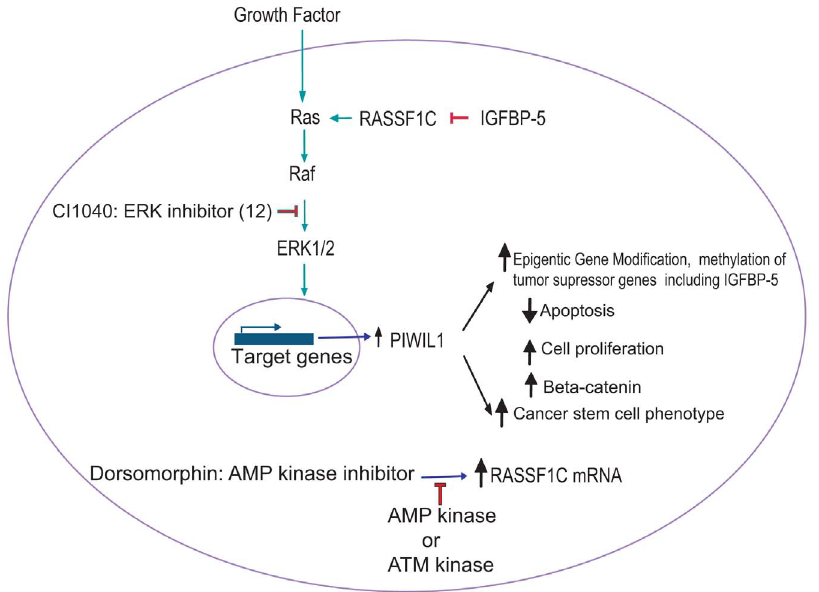
Figure 11. Proposed RASSF1C mechanistic pathway for lung cancer growth and progression. This model is based on our (12) and others previous published work and current data presented in this article. RASSF1C activates the MEK-ERK1/2 pathway (12), which controls a wide variety of genes that promote cell division and proliferation. Over-expression of RASSF1C up-regulates Piwil1 gene expression (12). Treatment of H1299 lung cancer cells with the MEK-ERK1/2 pathway inhibitor CI1040 resulted in down-regulation of Piwil1 mRNA levels (12). PIWIL1 is widely over-expressed in tumors compared to normal tissue, and it may have important functions in cancer initiation, maintenance, or progression (increased epigenetic gene modification, proliferation and cell migration, and reduced apoptosis). PIWI-like proteins have been shown to interact with PIWI-interacting RNAs (piRNAs) to form complexes that regulate transcriptional and translational repression leading to inhibition of apoptosis, stimulation of cell division and proliferation, and down-regulation of cyclin inhibitors and tumor suppressors (18). Over-expression of PIWIL1 down-regulates IGFBP-5 (18), which is an interacting partner and inhibitor of RASSF1C (19). Thus, co-expression of RASSF1C and IGFBP-5 abrogates the up-regulation of PIWIL1 expression in response to increased RASSF1C, suggesting that IGFBP-5 could block RASSF1C actions through the ERK1/2 pathway resulting in reduced PIWIL1 expression and function. Also, RASSF1C mRNA expression is regulated by AMP and ATM kinases. Various key components of the proposed RASSF1C pathway will be tested to validate this